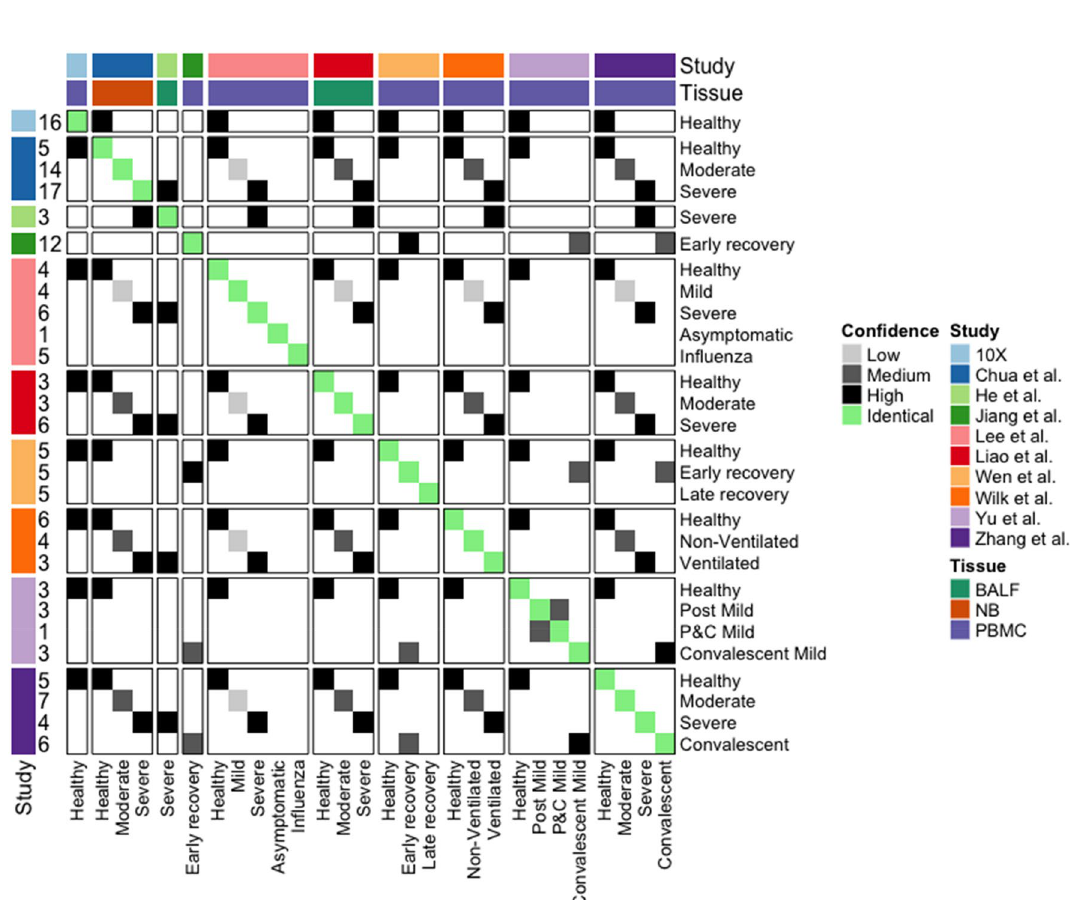
Figure 1. Cross study sample condition comparison. Mapping the conditions in the 10 studies given in Table 1. The number of samples are listed on the left, while the sample tissue types are colored on the top. The similarities between different conditions are colored from white to black (as from no similarity to high similarity). Here, “BALF” denotes samples derived from Bronchoalveolar lavage fluid, “NB” denotes samples derived from nasopharyngeal/bronchial tissue and “PBMC” denotes samples derived from peripheral blood mononuclear